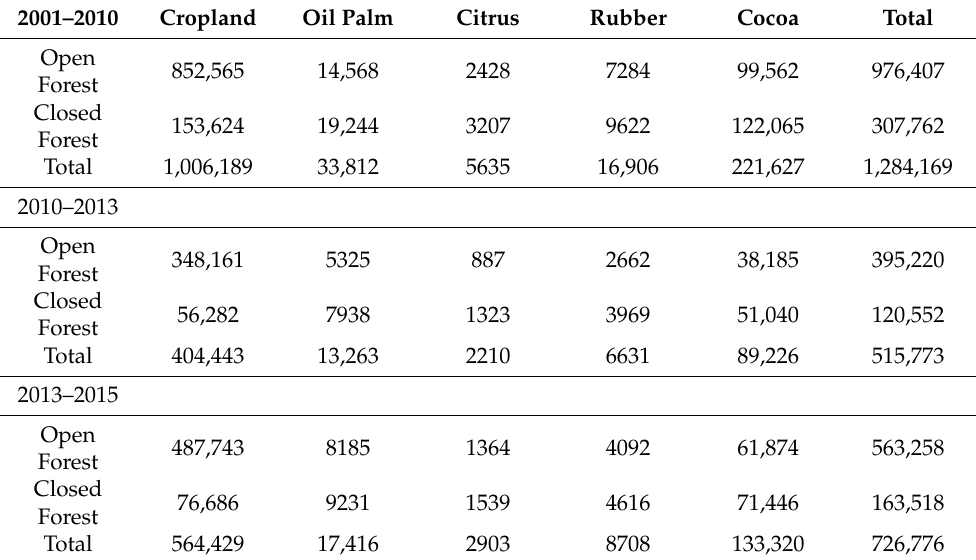
Table 2. Activity data for deforestation in Ghana between 2000 and 2015.